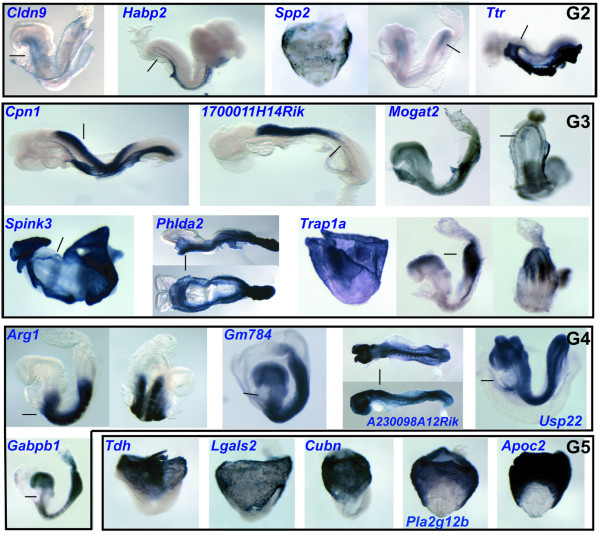
Whole mount in situ hybridization validation of the 2nd candidate list, illustrating the complex expression patterns of endoderm genes. For explanation see text and Table 2. The DE expressions of the genes in Groups 2–4 are shown further by histological sections in Figure 7.